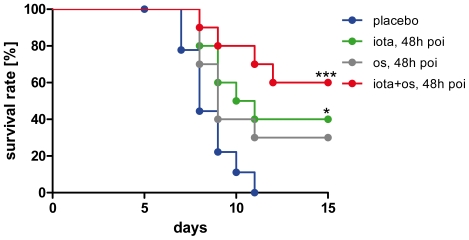
Efficacy of iota-carrageenan in mice in comparison to oseltamivir.Ten mice per group were intranasally infected with 8.7×103 PFU H1N1/PR/8/34 viral particles at day 0 and therapy started 48 h poi (blue indicates the placebo treatment). In addition to the group with intranasal treatment twice daily with 60 µg iota-carrageenan (green), a group of mice also received an oral dose of oseltamivir (10 mg/kg/day in 5% sucrose) (grey) twice daily for 5 days, and accordingly in combination with iota-carrageenan (red). P values were calculated by a Log-rank (Mantel-Cox) test. Survival was monitored daily for 15 days. Asterisk, p<0.05; triple asterisk p<0.001.